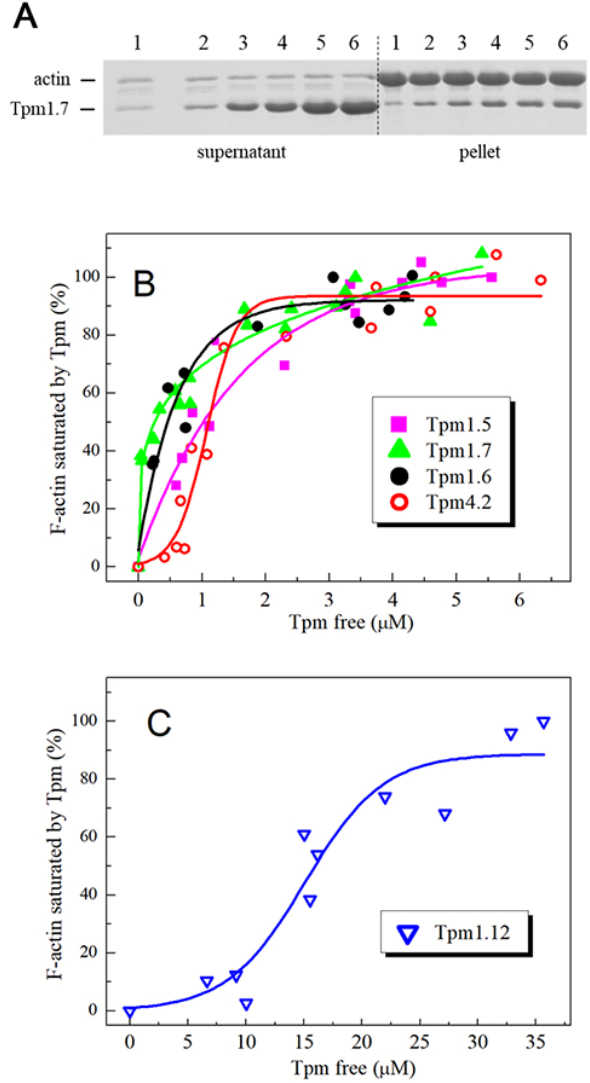
Figure 4. The affinity of various Tpm isoforms for F-actin. Plot ( A ) shows a representative SDS-PAGE gel for experiment of cosedimentation of Tpm1.7 isoform with F-actin. The numbers 1–6 above the lanes for supernatants and pellets correspond to concentrations of Tpm1.7 (0.5 µ M, 1 µ M, 2 µ M, 3 µ M, 4 µ M, and 6 µ M, respectively) added to F-actin before ultracentrifugation. Plots ( B ) and ( C ) show the actin affinity of Tpm isoforms Tpm1.5, Tpm1.6, Tpm1.7, and Tpm4.2 ( B ), and Tpm1.12 ( C ) determined by the cosedimentation assay and plotted as the fractional saturation of F-actin by Tpm as a function of free Tpm concentration that was found in the supernatant.